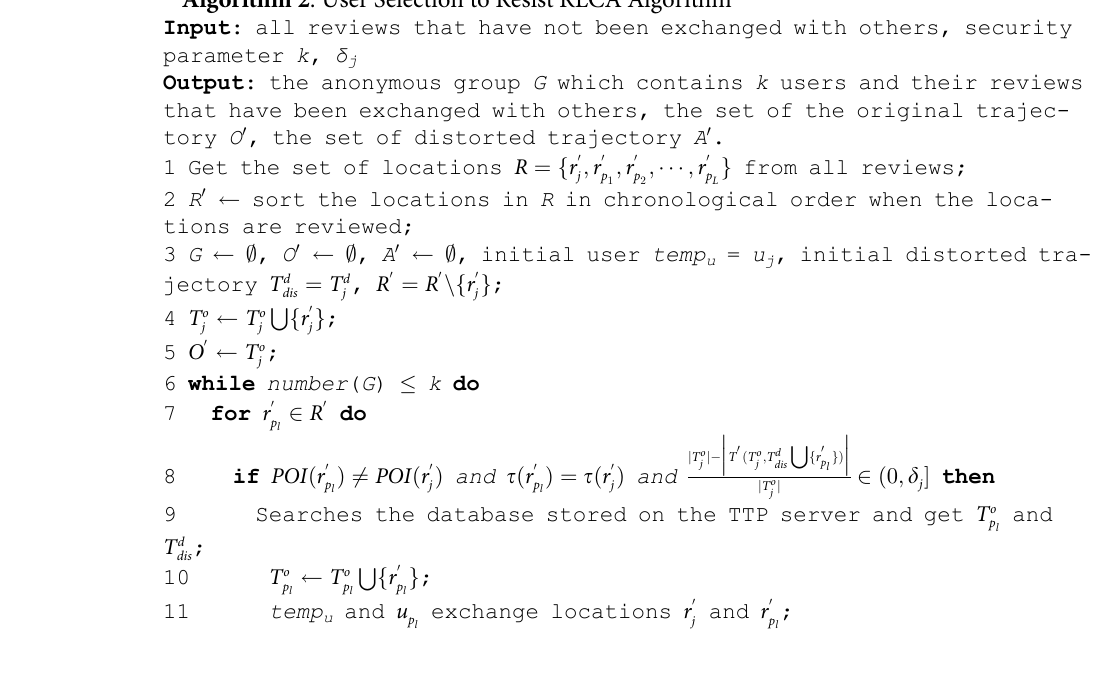
Algorithm 2 : User Selection to Resist RLCA